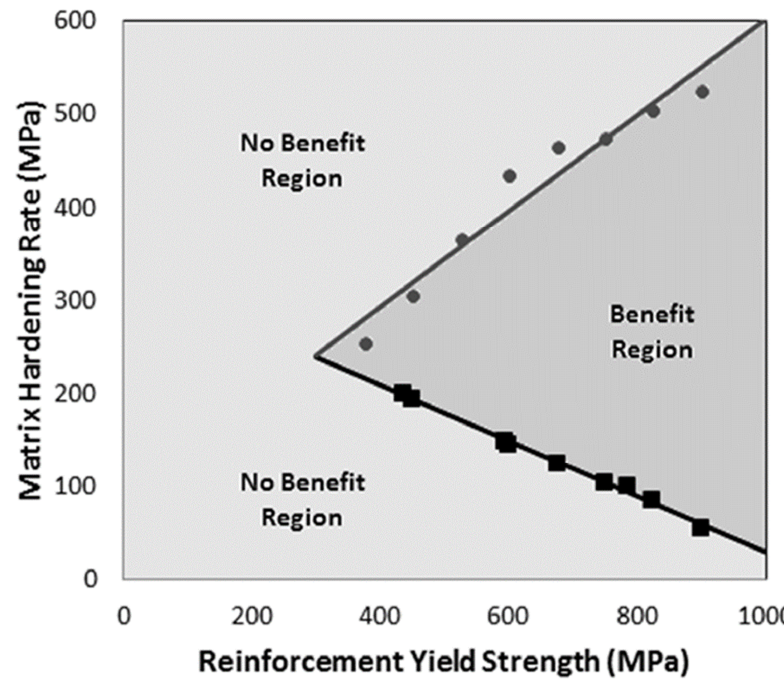
Figure 8. Benefit map showing regions of material property values in which gains in necking strain are achieved through corrugation. This map represents a system with a fixed matrix yield strength at 300 MPa and a reinforcement hardening rate at 500 MPa along with a constant corrugation geometry with a corrugation height of 3 mm, period of 8 mm, thickness of 0.78 mm, and volume fraction of 20%.